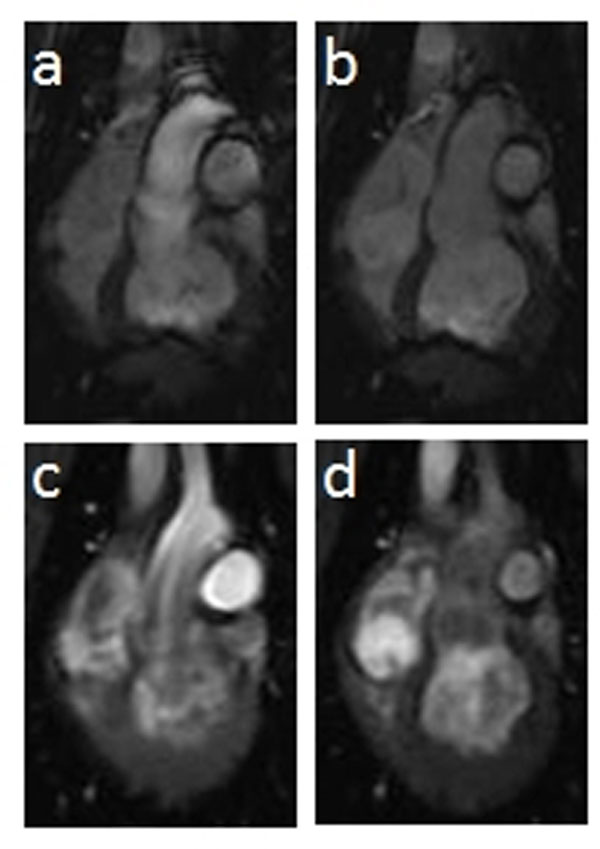
2D bSSFP images (a. Amax and b. Amin) and 2DPC images (c.Amax and d. Amin).